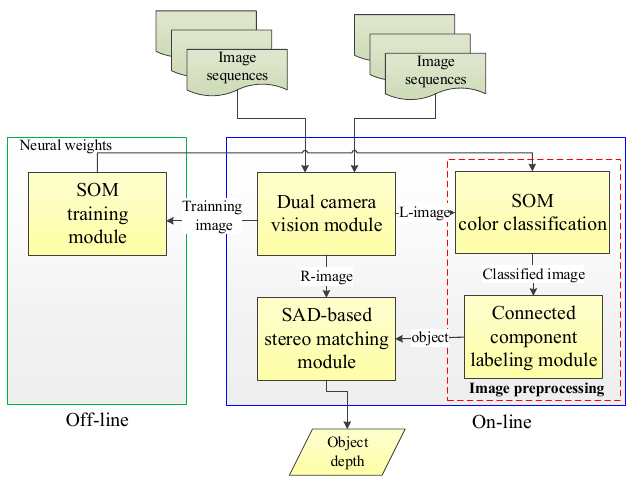
Figure 1. System structure of the proposed embedded stereo system.